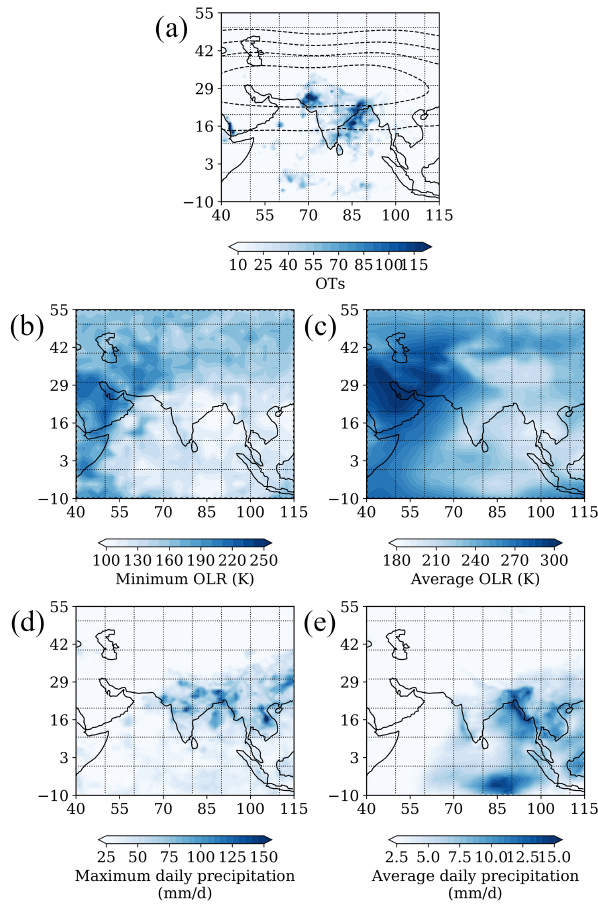
Figure 2. The geographic distribution of convection over the Asian monsoon region during the study period (1 May through 31 Oc- tober 2017). Cross-tropopause convection is shown in panel (a) . The colorbar shows OT frequency, evaluated in 1 ◦ × 1 ◦ bins, within the satellite observation window. Also shown is the average Mont- gomery potential stream function at 400K for the months of JJA (dashed black contours from 3 . 59 × 10 5 m 2 to 3 . 63 × 10 5 m 2 s − 2 by 0 . 01 × 10 5 m 2 s − 2 ) to illustrate the location of the Asian mon- soon anticyclone. The minimum and average daily OLR values are shown in panels (b) and (c) , respectively. The minimum and average daily precipitation are shown in panels (d) and (e) ,